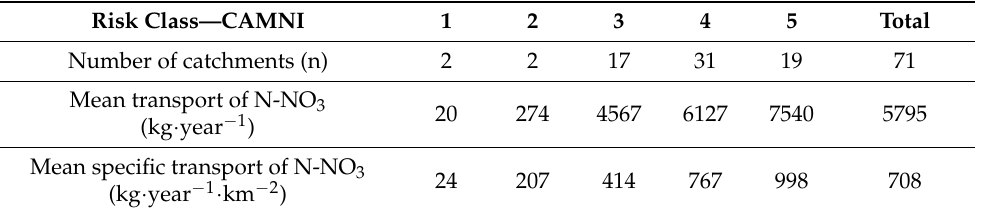
Table 5. Nitrate loads the fourth-order Blanice river catchments according to CAMNI risk classes. Risk